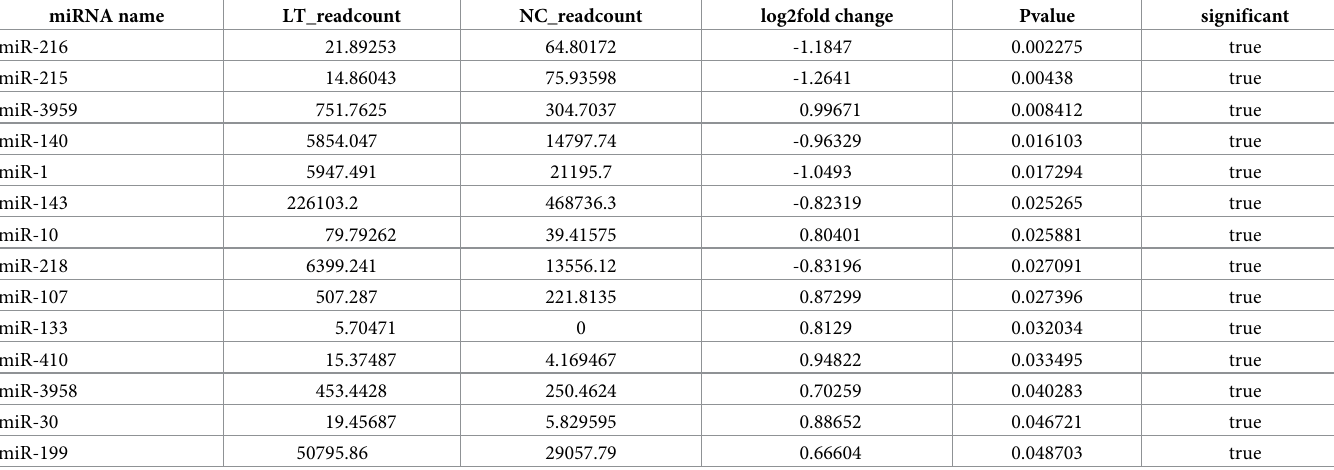
Table 3. Significant differentially expressed known miRNA between light control and normal group.